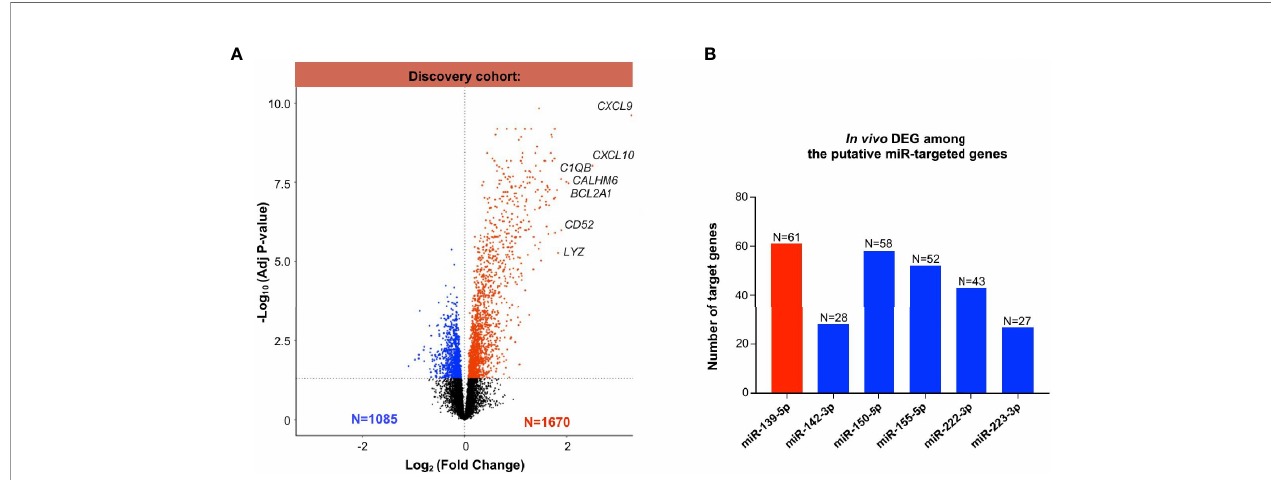
FIGURE 3 | Whole transcriptomic analysis from identical allograft biopsy samples: mRNA/miRNA integration. (A) Volcano Plot showing the differentially expressed (DEG) analysis between MVI+ and MVI- samples in the discovery cohort. Blue dots: decreased expression in MVI+. Red dots: increased expression in MVI+. Black dots: non-signi fi cant differential expression. (B) Integration of miRNAs and mRNAs revealed in vivo validated target genes of each individual miRNAs. In silico putative target genes of miR-139-5p were intersected with MVI-upregulated genes (red color) whereas putative targets genes of miR-142-3p, 150-5p, 155-5p, 222-3p and 223-3p were intersected with MVI-downregulated genes (blue color). The number of target genes of each list is